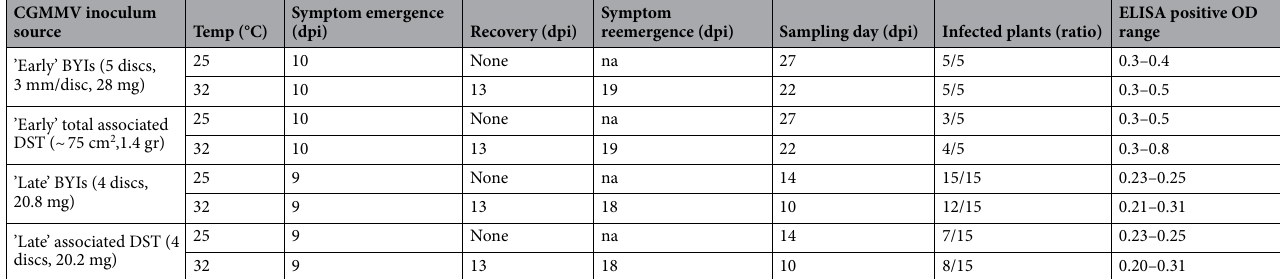
Table 1. An infectious potential of CGMMV in BYIs and the corresponding dark green surrounding tissues of early and late post-recovery stages, determined in biological assays. ’Early’ early post-recovery stage, ’Late’ late post-recovery stage, DST dark surrounding tissues, dpi days post inoculation, na not applicable, ELISA negative reference OD range was 0.06–0.09; in brackets, numbers of collected discs, total disk weights and sizes of discs or leaf